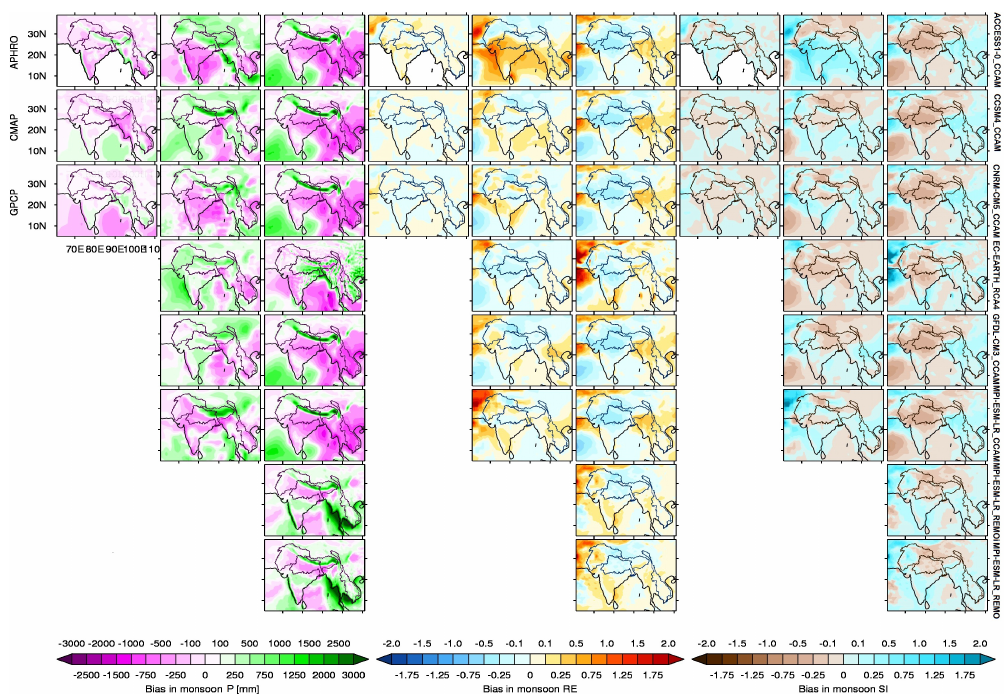
Figure 8. Offsets of precipitation (P), relative entropy (RE) and seasonality index (SI) for OBS, CMIP5 and CX-SA datasets from the OBS mean ensemble for the monsoonal precipitation